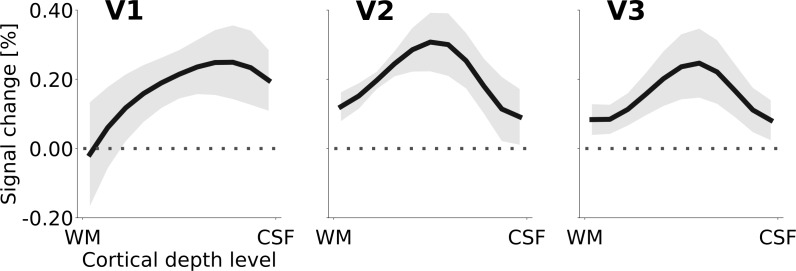
Cortical depth profiles of the apparent motion effect for the cortical representation of the stimulus centre (see Figure 2C & D).The apparent motion effect was defined as the relative signal change associated with the condition contrast ‘motion induction’ (Figure 1A) minus ‘dynamic control’ (Figure 1C). Shading represents the standard error of the mean (across subjects). See Figure 4—figure supplement 1 for the same results for all experimental conditions, Figure 4—figure supplement 3 for single subject data, and Figure 4—figure supplement 2 for the cortical depth profile of the apparent motion effect at the representation of the stimulus edge.